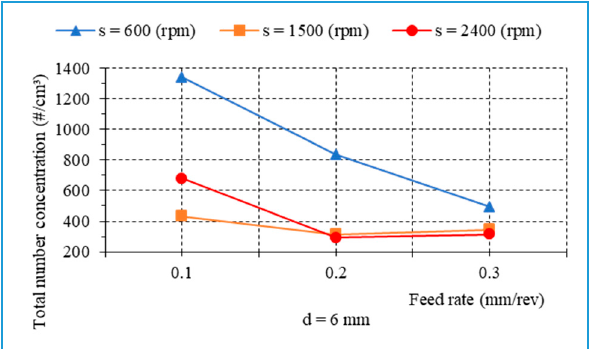
Figure 18. Main effect plot for fine particles emission.